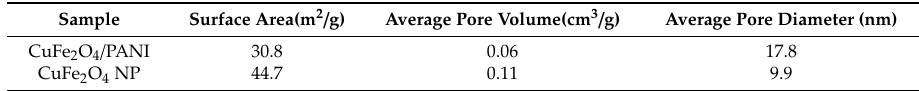
Figure 3. N 2 adsorption–desorption isotherms of coupled CuFe 2 O 4 and CuFe 2 O 4 /PANI (polyaniline) nano-composites. Table 1. General surface characteristics of CuFe 2 O 4 and CuFe 2 O 4 / PANI nano-composites obtained by N 2 adsorption at 77